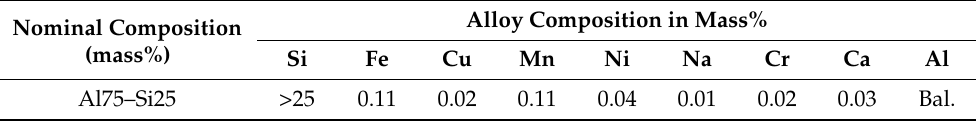
Table 2. Chemical composition of Al–25 mass%Si master